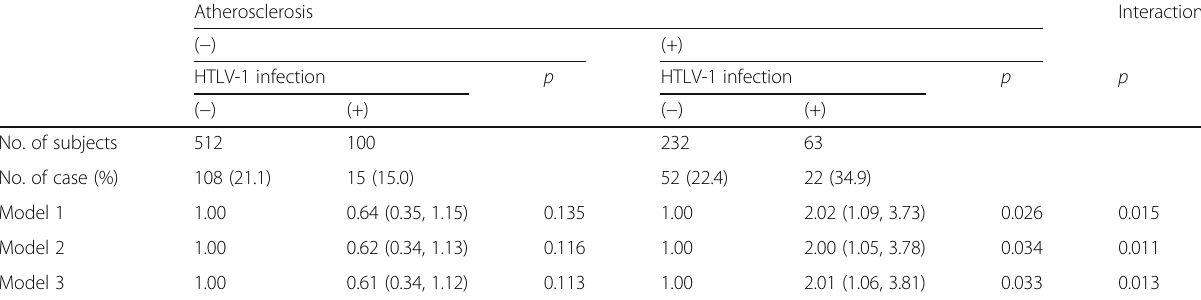
Table 4 Odds ratios (ORs) and 95% confidence intervals (CIs) for advanced periodontitis in relation to human T cell leukemia virus type-1 (HTLV-1) infections by status of